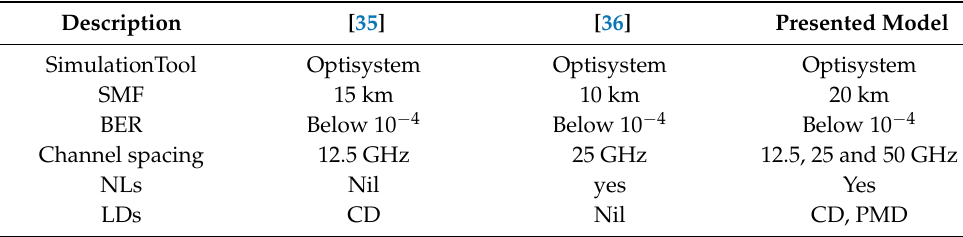
Table 3. Performance analysis of the proposed model in terms of current